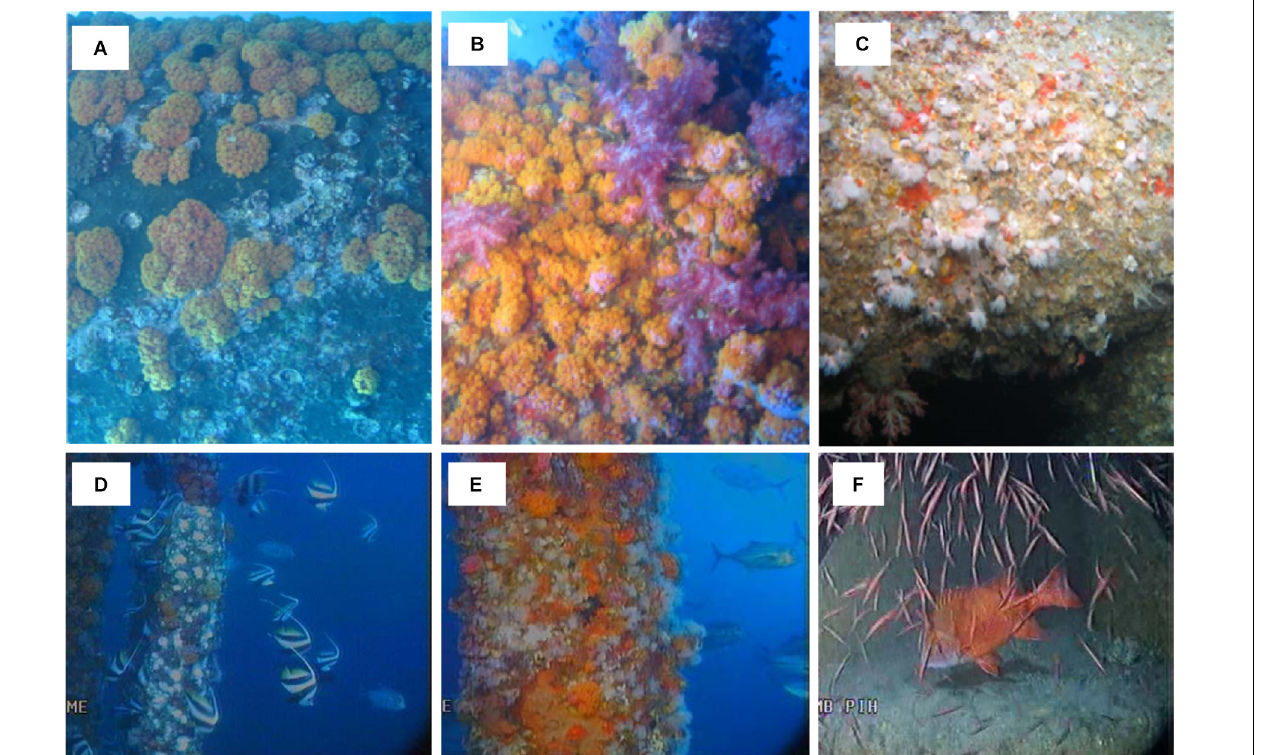
Frontiers in Marine Science |